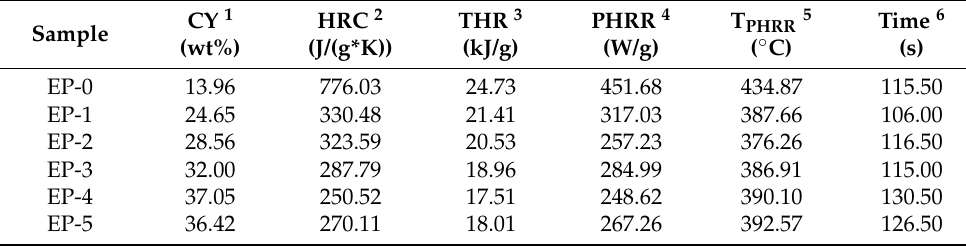
Table 3. Data obtained by MCC analysis for the epoxy thermosets.